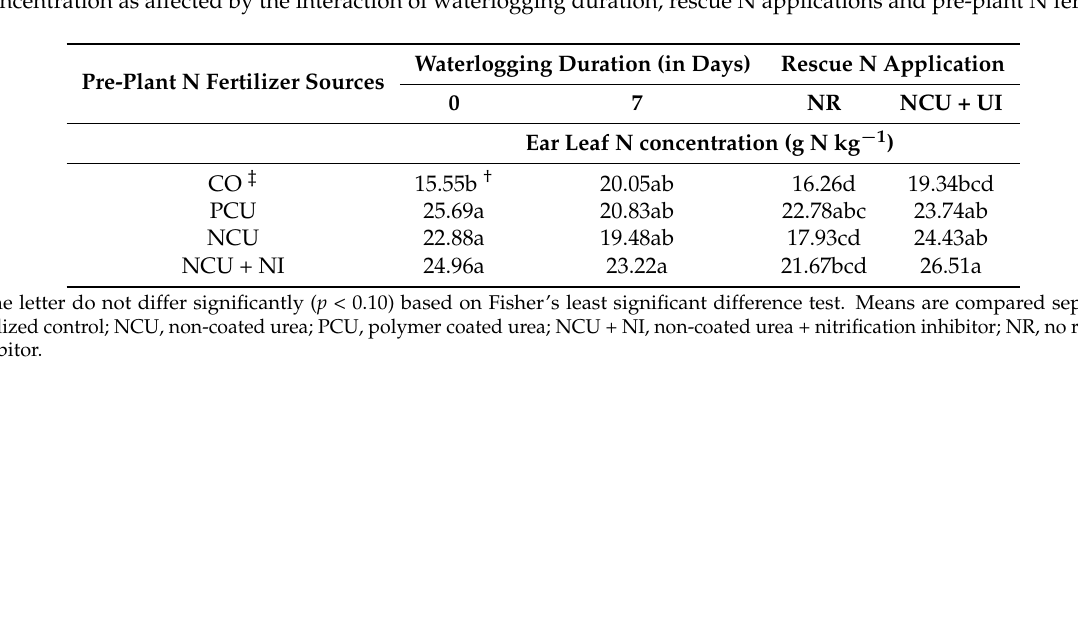
Table 5. Ear leaf N concentration as affected by the interaction of waterlogging duration, rescue N applications and pre-plant N fertilizer sources in